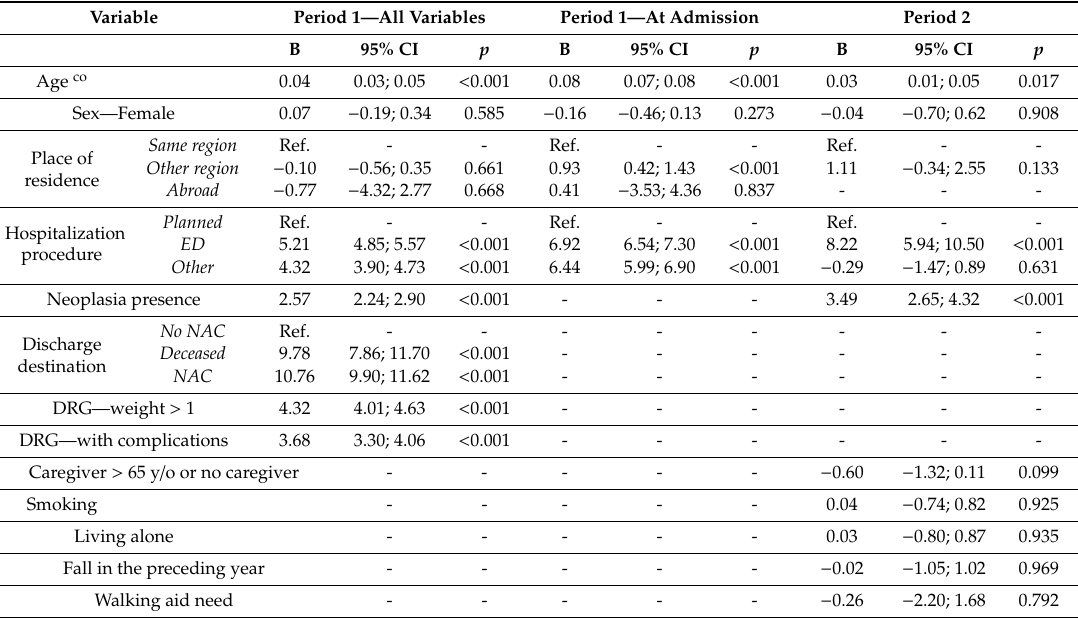
Table 3. Table 2. Length of stay (LOS) outcomes—linear regression models.